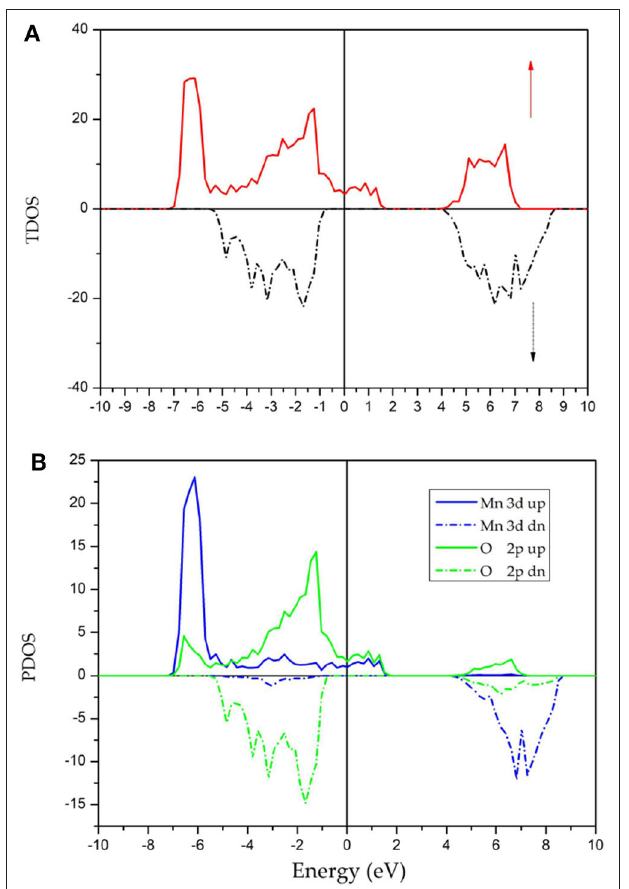
FIGURE 4 | Calculated TDOS (A) and PDOS (B) of GdMnO 3 obtained using the DFT + U method. Because the GdMnO 3 system contains heavy atoms, the effect of the spin-orbit coupling (SOC) should be discussed in this work. Figure 5 shows the band structures of GdMnO 3 obtained